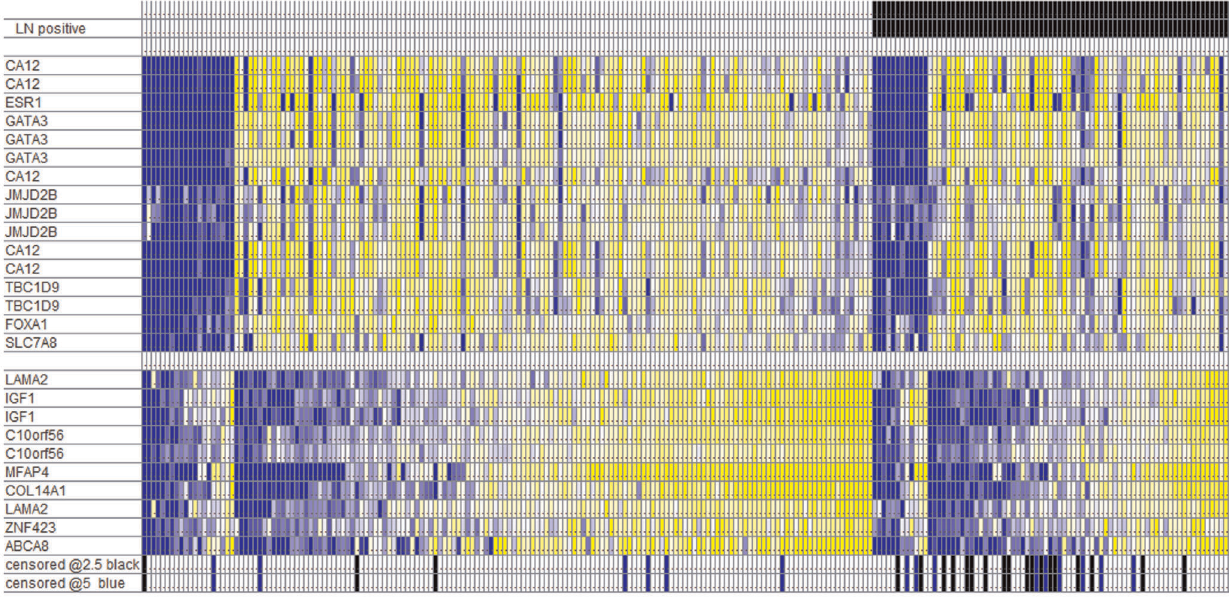
Figure 1. Uppsala samples partitioned by lymph node status and estrogen-status, ordered on stromal-laminin gene expression. Yellow signifies up-regulation; blue signifies down-regulation. Rows represent probe sets on the Affymetrix HG U133A platform. Black bars record Breast Cancer Specific Survival events censored at 2.5 years. Blue bars record BCSS events that occur between 2.5 and 5 years.